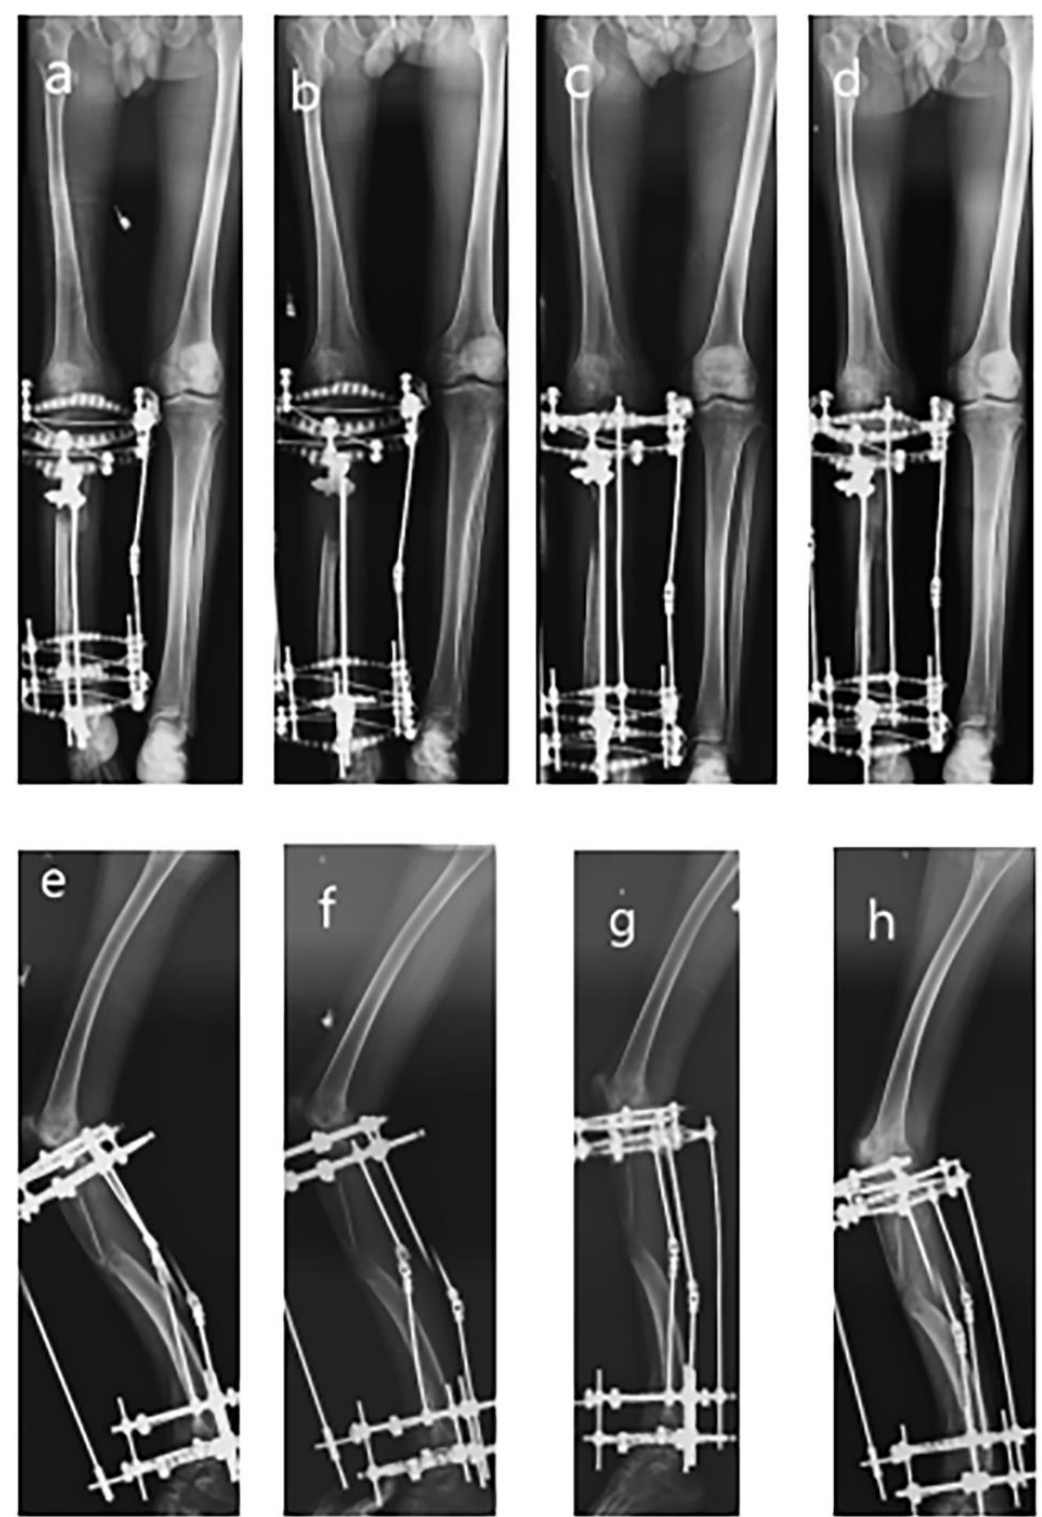
Figure 2. Series radiographs of the lower extremity after Ilizarov apparatus instalment. ( a ) AP view radiograph of 5th-month follow-up; ( b ) AP view radiograph of 8th-month follow-up; ( c ) AP view radiograph of 9th-month follow-up; ( d ) Lateral view radiograph of 10th-month follow-up; ( e ) Lateral view radiograph of 5th-month follow-up; ( f ) Lateral view radiograph of 8th-month follow-up; ( g ) Lateral view radiograph of 9th-month follow-up; ( h ) Lateral view radiograph of 10th-month follow-up.